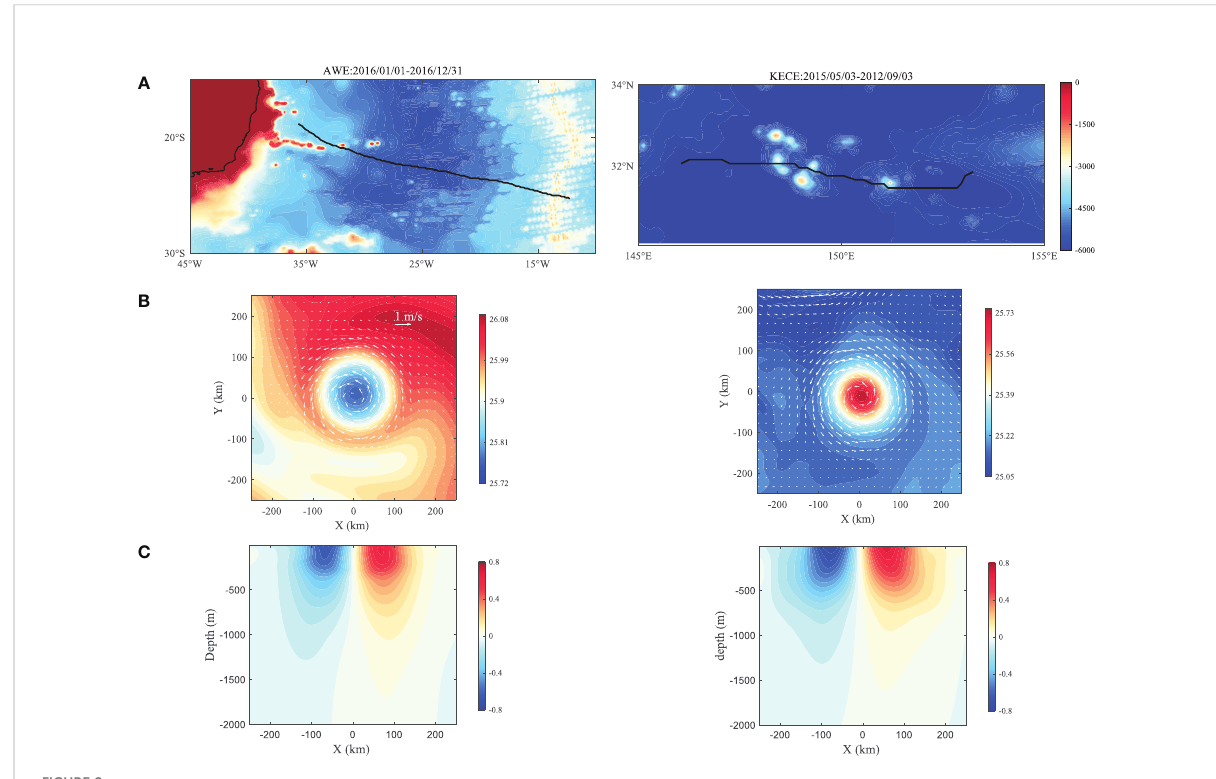
FIGURE 2 (A) Tracks (black lines) of the Agulhas warm eddy (AWE, left panel) and Kuroshio extension cold eddy (KECE, right panel), and time-mean (B) potential density (shading) and horizontal velocity (vectors) at the depth of 200 m, and (C) vertical distribution of meridional velocity across the center of the AWE (left panel) and KECE (right panel) in the zonal direction. The color in (A) denotes